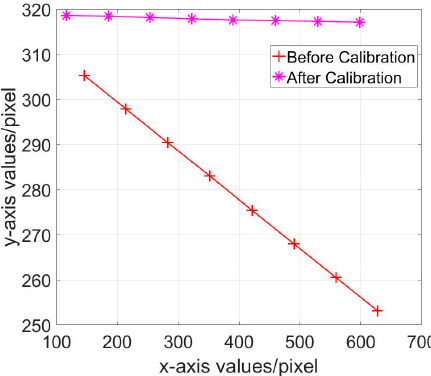
Figure 13. Coordinate change before and after horizontal calibration.